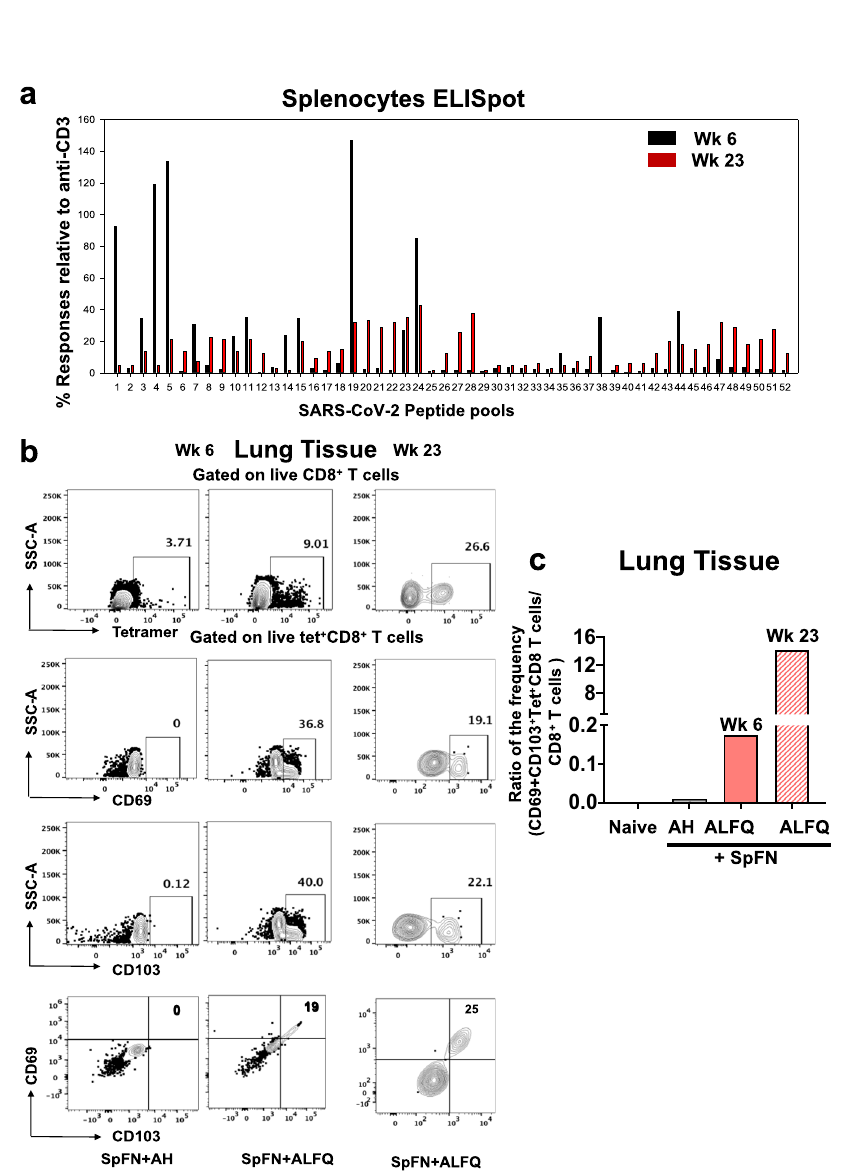
Fig. 8 ELISpot Responses in splenocytes and SARS-CoV-2K b spike (539 – 546) -speci fi c MHC class I restricted CD8 + T cells in perfused lungs of SpFN prime-boost vaccinated mice at weeks 6 and 23. a Number of spike-speci fi c IFN- γ spot forming units in week 6 and week 23 splenocytes stimulated with 52 peptide pools from the Epitope Mapping Peptide Set of the spike protein. The data were presented as % response relative to a number of spots produced with anti-CD3. b Frequency of SARS-CoV-2 spike (539 – 546) - speci fi c tetramer-positive CD8 + T cells in lung tissue of SpFN + AH and SpFN + ALFQ vaccinated mice at weeks 6 and 23 as determined by fl ow cytometry. SARS-CoV-2 spike fi c tetramer staining was followed by CD69 and CD103 staining. A representative fi gure is shown for each week. c The ratio of (539 – 546) - speci the frequency of CD69 + CD103 + Tet + CD8 + T cells to CD8 + T cells is shown for Naïve (unimmunized), SpFN + AH at week 6, and SpFN + ALFQ at weeks 6 and 23 post- fi rst